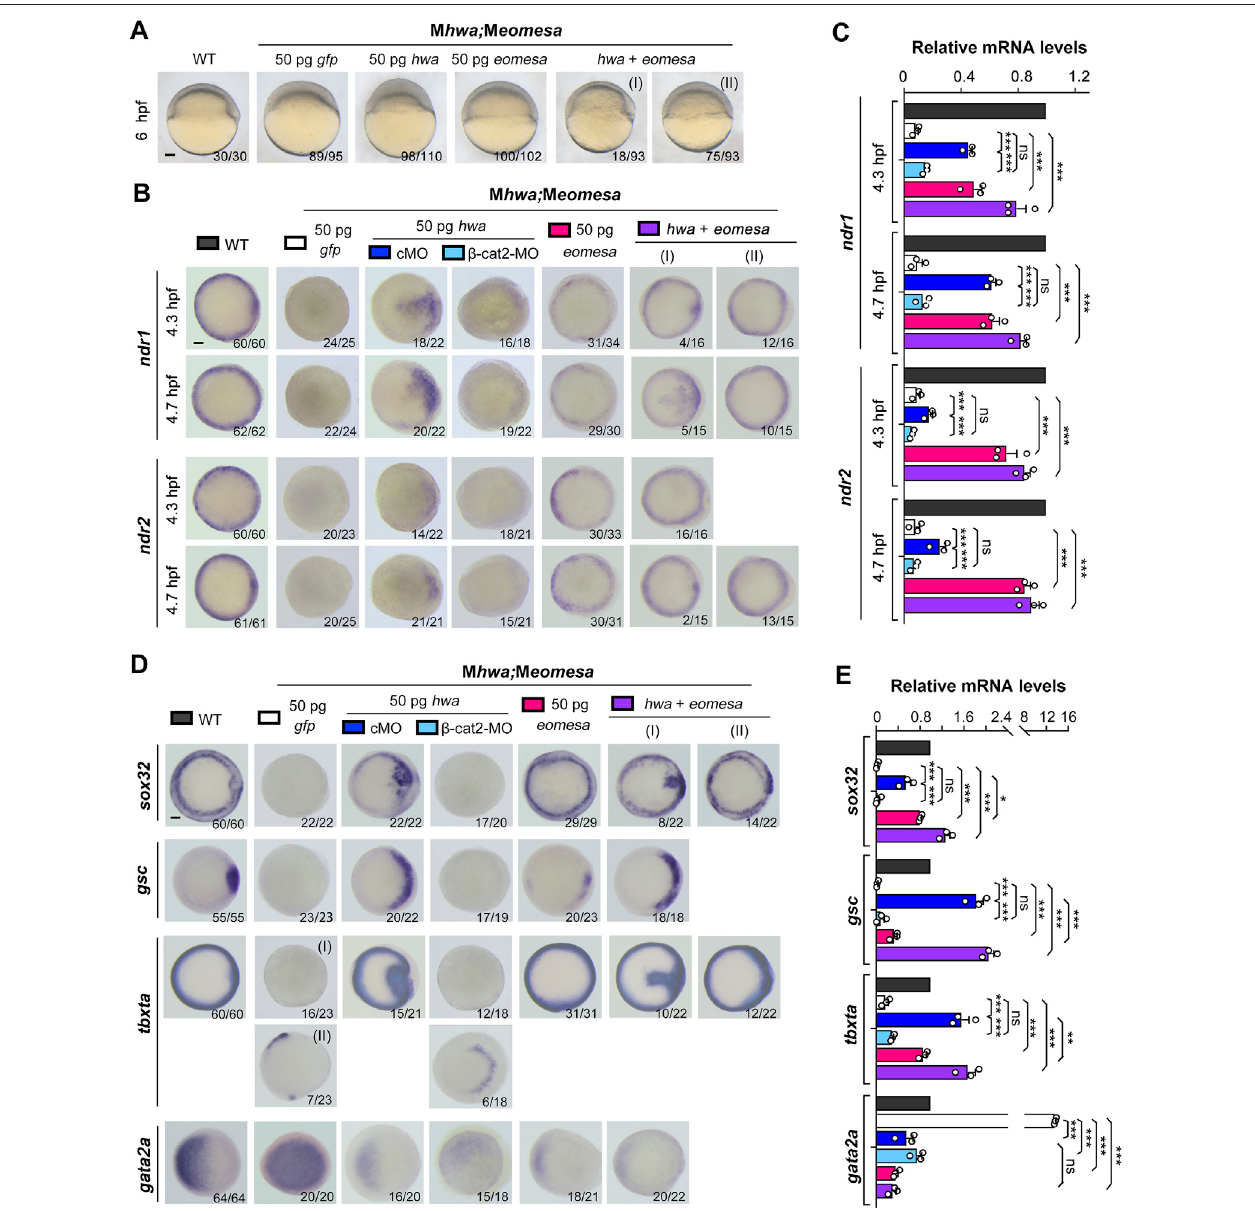
FIGURE 3 | Induction of nodal genes and mesendodermal markers in M eomesa; M hwa mutants by ectopic hwa or/and eomesa. One-cell stage mutant embryos wereinjected withcorrespondingmRNAor/andMO and observed formorphologyat 6hpf (A) orharvestedat indicatedstages fordetection ofselectedgenesbyWISH (B,D) orbyRT-PCRanalysis (C,E) .Embryoswerepositionedlaterally (A) orinanimal-poleview (B,D) withdorsaltotherightifthedorsalsidewasperceptible.Theratioof embryos with the representative pattern was indicated in the right bottom. Scale bars: 100 μ m. Injection doses of mRNA or MO: hwa and myc-eomesa , 50 pg/ embryo;cMO(ascontrolMO)and β -cat2-MO,20ng/embryo.qRT-PCRanalysiswasperformedusing15embryospersample,andtheexpressionlevelwasnormalized tothatof eif4g2a inWTembryosatthesamestage.ErrorbarsindicatedS.D.basedonthreebiologicalreplicates(indicatedbysmallcircles).Colorkeysforembryotypes and treatments were shown in (A,B,D) . Statistically signi fi cant level: ns, nonsigni fi cant; *, p < 0.05; **, p < 0.01; ***, p <